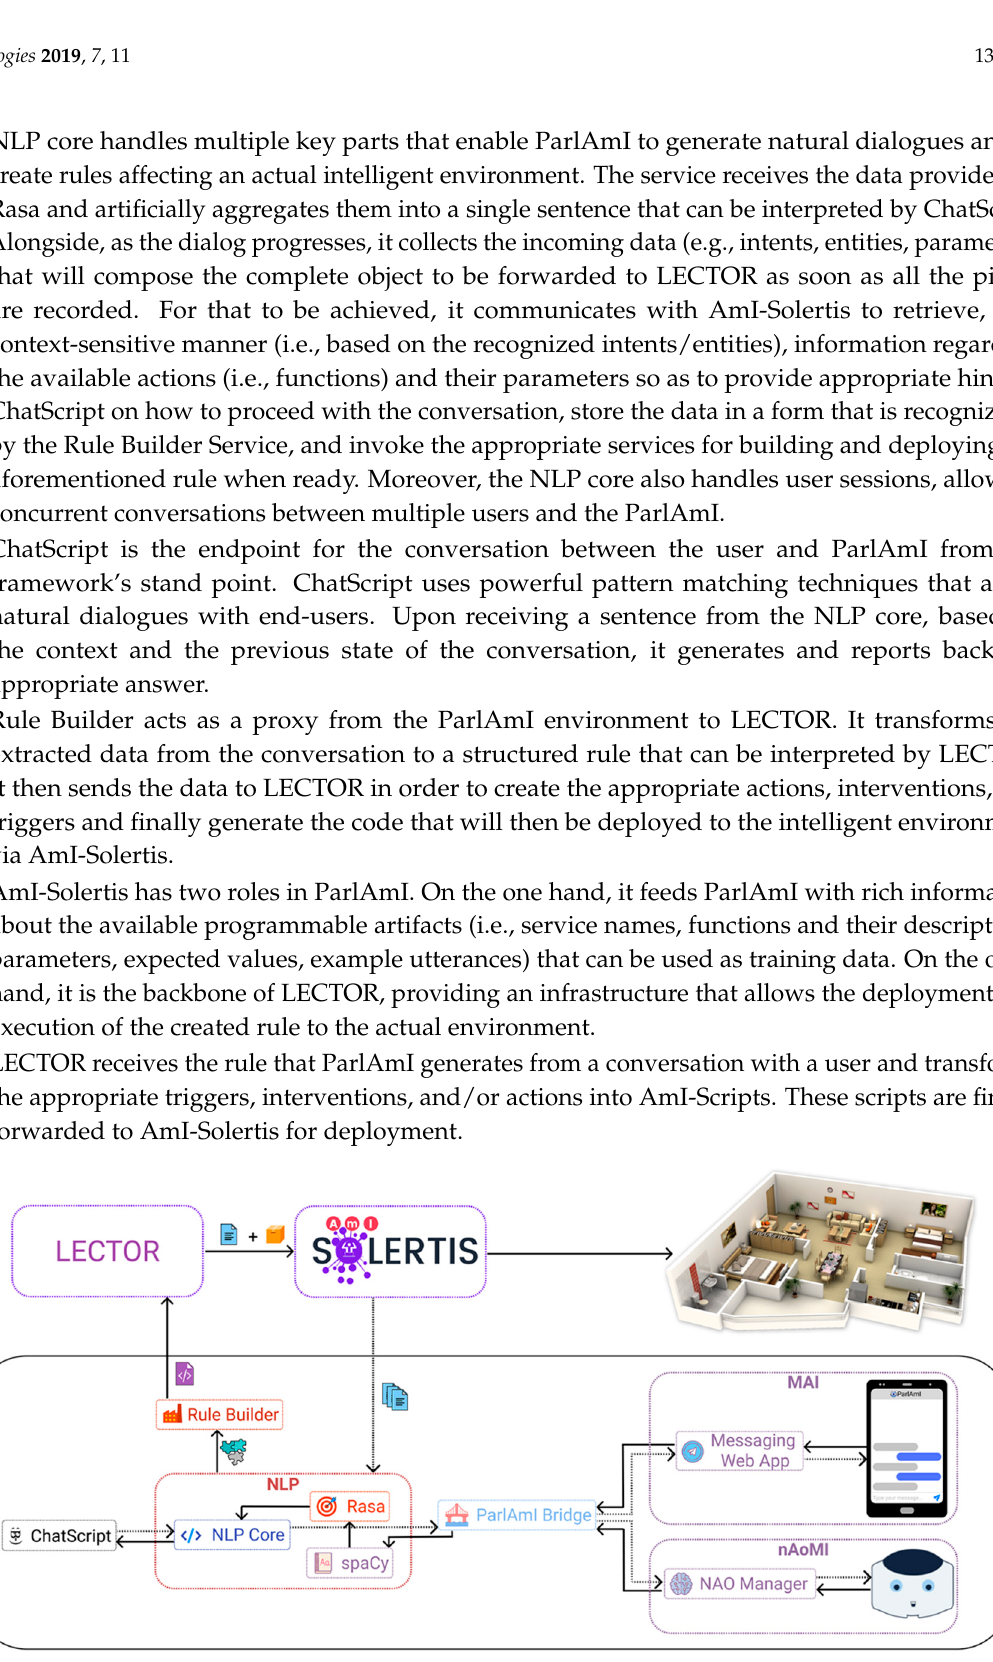
Figure 3. ParlAmI’s architecture.